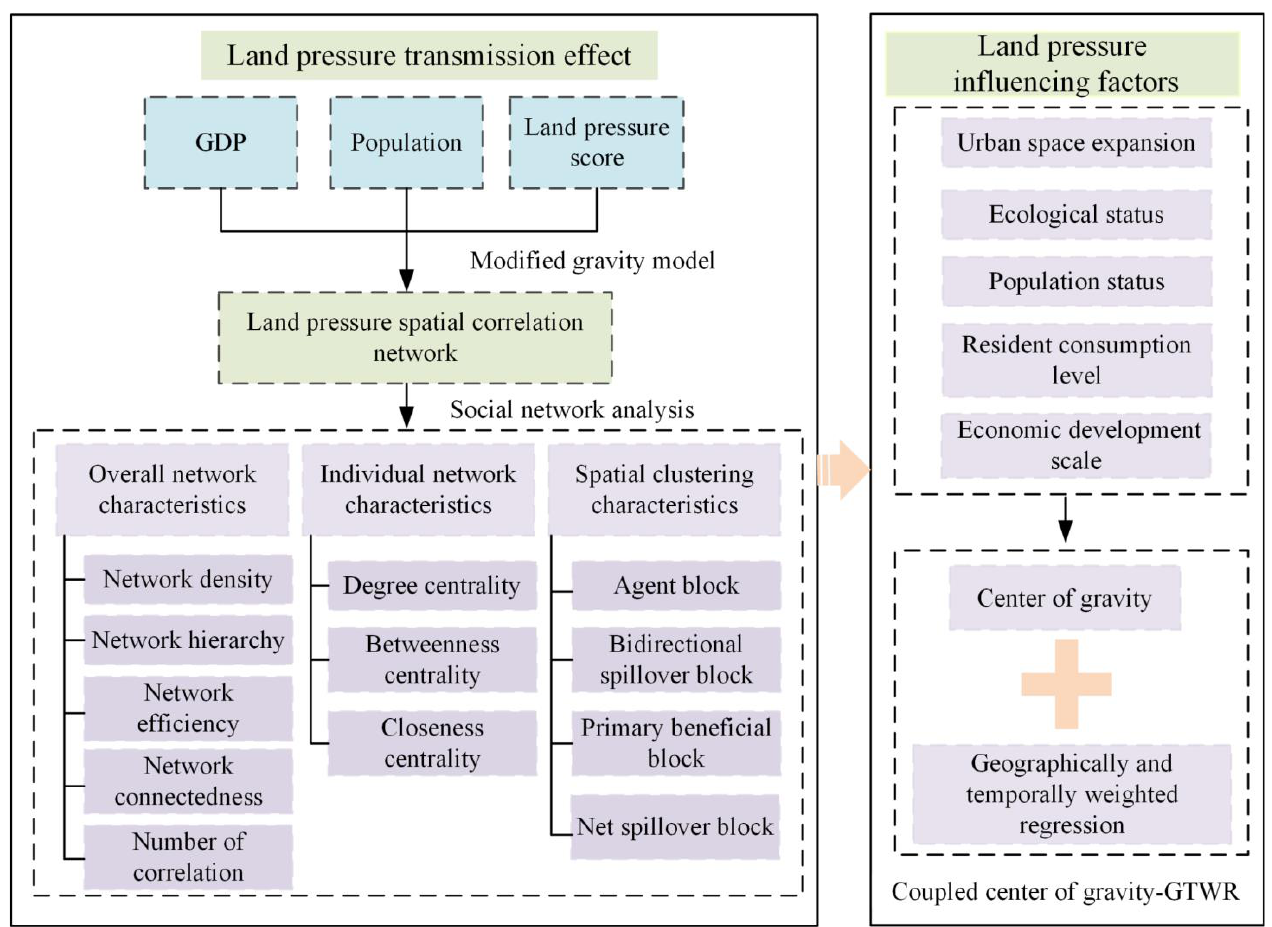
Figure 2. Flow chart of land pressure transmission effects and influencing factors from 1995 to 2020.